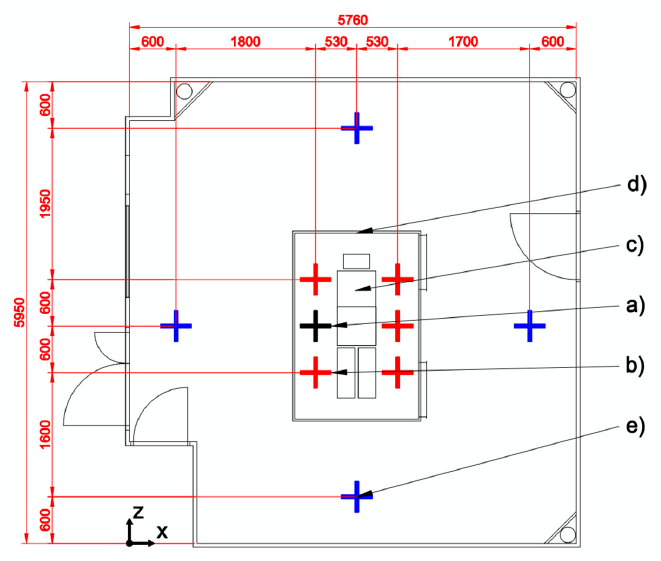
Figure 8. Measurement positions: (a) thermal comfort of the surgeon, (b) thermal comfort of the assistant surgeon (c) operating table, (d) LAFC (e) additional measurement of the thermal-humidity microclimate parameters.